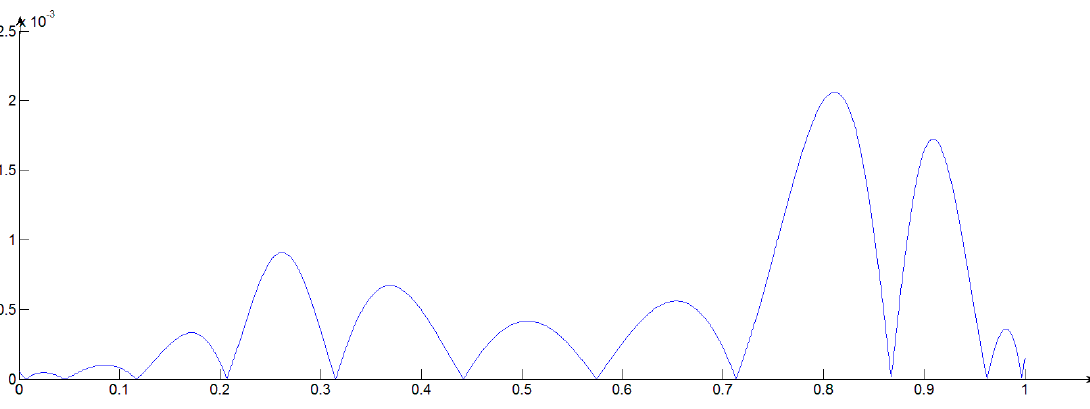
Figure 3. Fluctuation curve of the direction